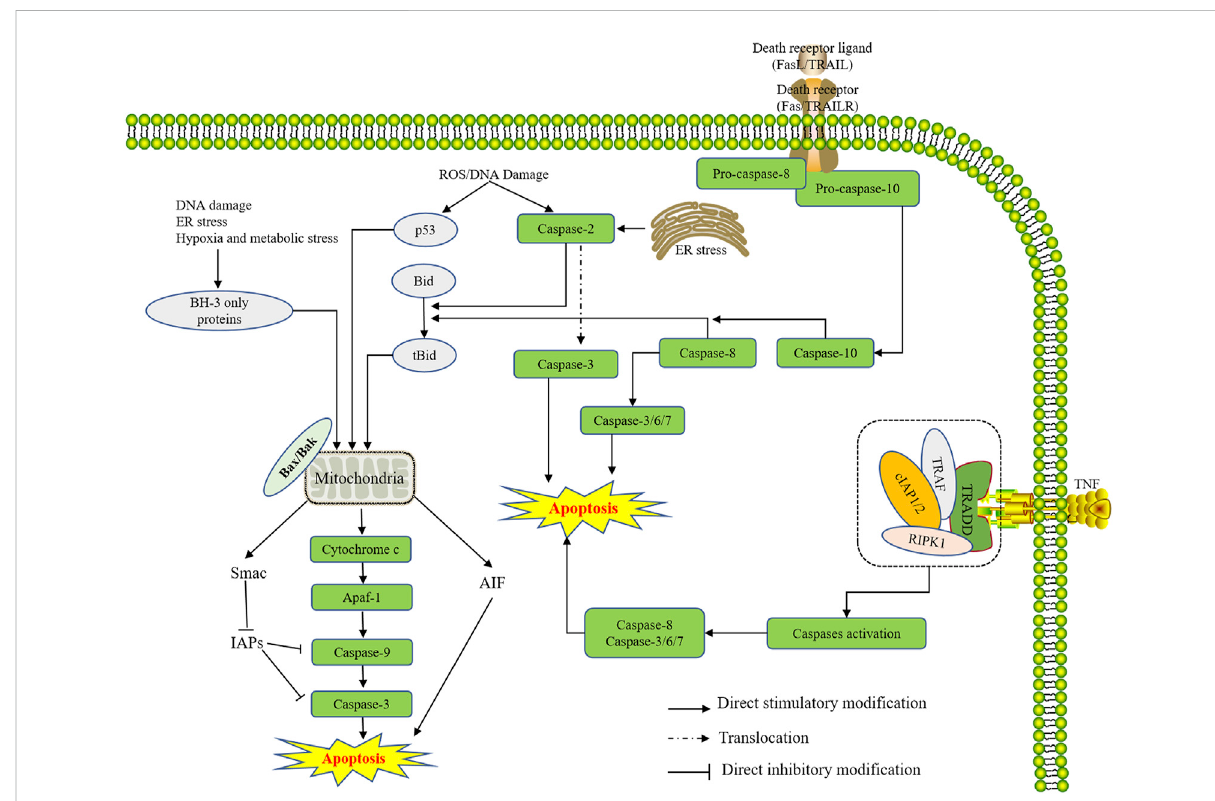
FIGURE 2 Endogenous and exogenous apoptotic events are involved in ischemic cardio-brain injuries. Major apoptosis pathways include mitochondria- dependentanddeathreceptor-mediated.Theseapoptosispathwaystogetherinteractedmutuallywhenischemicdiseasesoccurred.Fortheformer, hypoxia-induced ROS surge and DNA damage directly activated caspase-2 and downstream Bid-activated mitochondrial apoptosis. In parallel, the activatedp53also stimulatedthemitochondrialapoptoticprocess. Meanwhile,DNAdamage,ERstressandhypoxiametabolic stresscanevoke the mitochondrial apoptosis pathway by activating BH-3 only protein. As for the speci fi c process of mitochondrial apoptosis, Bax and Bak dimers induced byhypoxiaformedthechannelsofcyt-c and AIF inandout onthemitochondrialmembrane,which furtherinfuriatedtheoverexpression of Apaf-1, caspase-9 and the apoptosis executor caspase-3 to seduce apoptosis. On the contrary, the increased Smac could negatively inhibit IAPs to furthersubduemitochondrialapoptosis.Forthelatter,pro-caspase-8andpro-caspase-10couldbeactivatedbythecombinationofdeathreceptors (FasL/TRAIL) and death ligands (Fas/TRAILR). Together with ER stress and caspase-2, caspase-3/6/7 was thus triggered to result in apoptosis. On the other hand, the formation of TRADD, TRAF, CIAP1/2 and RIPK1 complexes activated by TNF can also lead to apoptosis by irritating